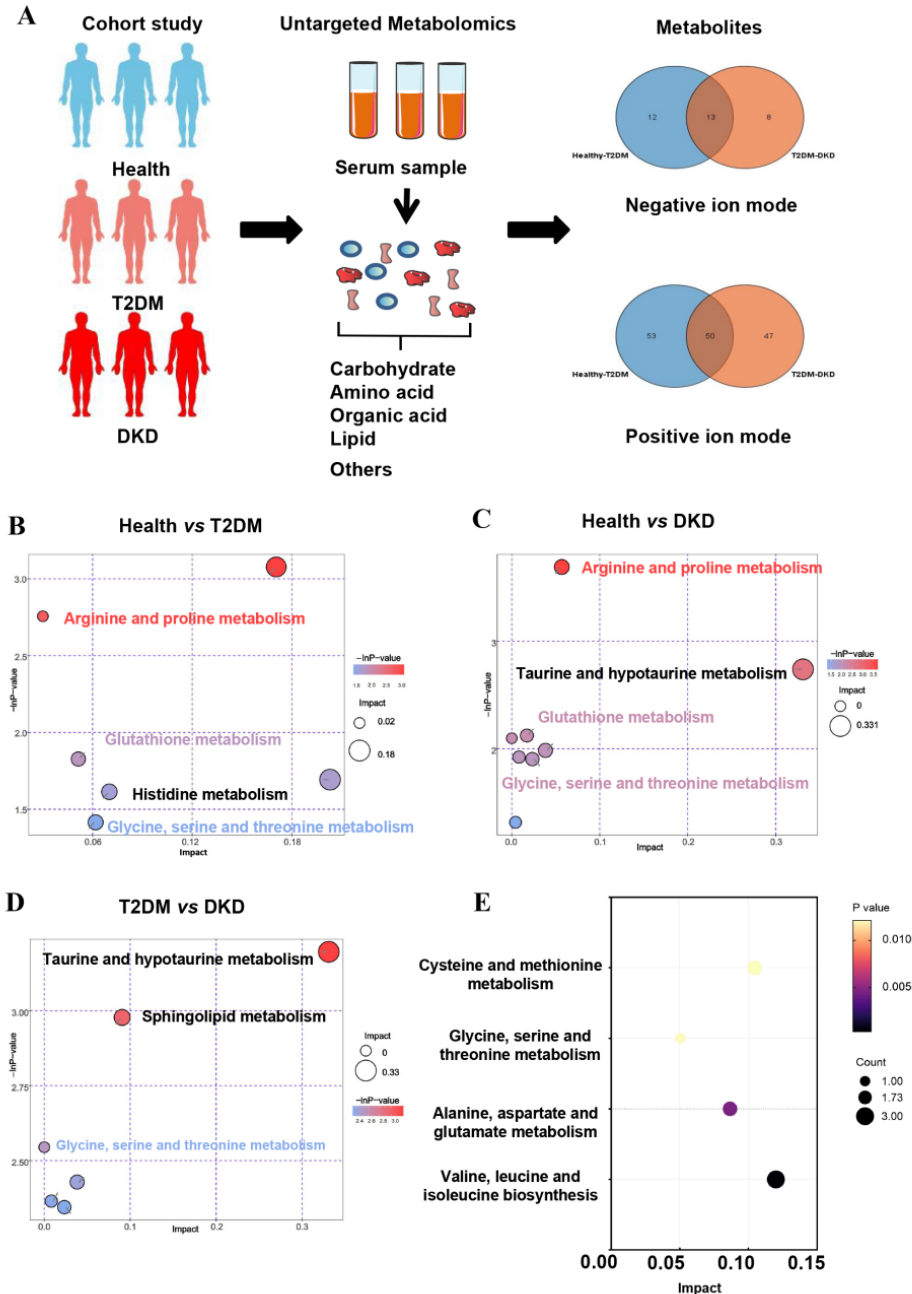
Figure 1. Overview of metabolic alterations in T2DM and DKD. ( A ) A Study design